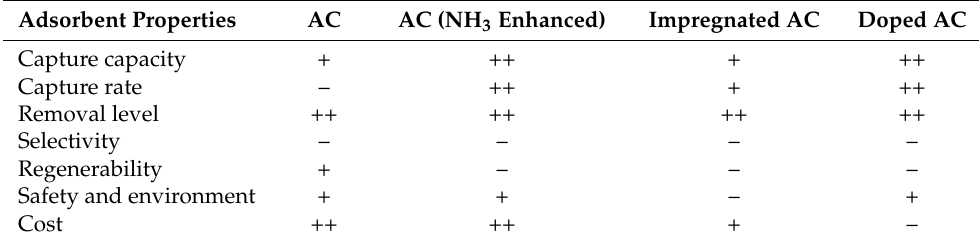
Table 7. Comparison of standard AC, ammonia-enhanced AC, impregnated AC and doped AC for low-temperature syngas H 2 S removal. Favorable characteristics are indicated with the ++/+ sign and the—sign for unfavorable